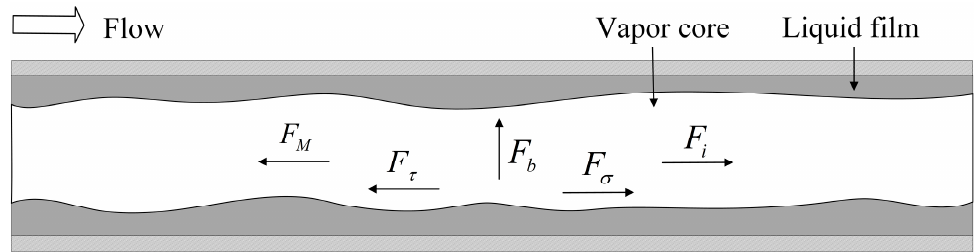
Figure 8. Schematic diagram of the force analysis of the vapor-liquid interface in the annular flow region in the microchannel.